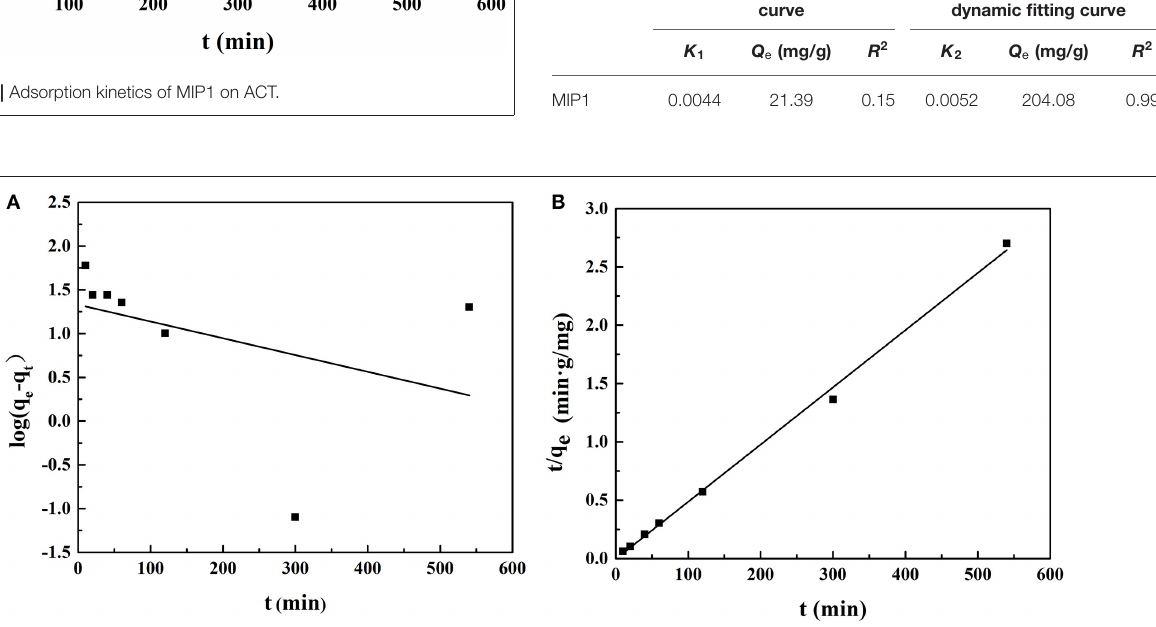
Frontiers in Chemistry |